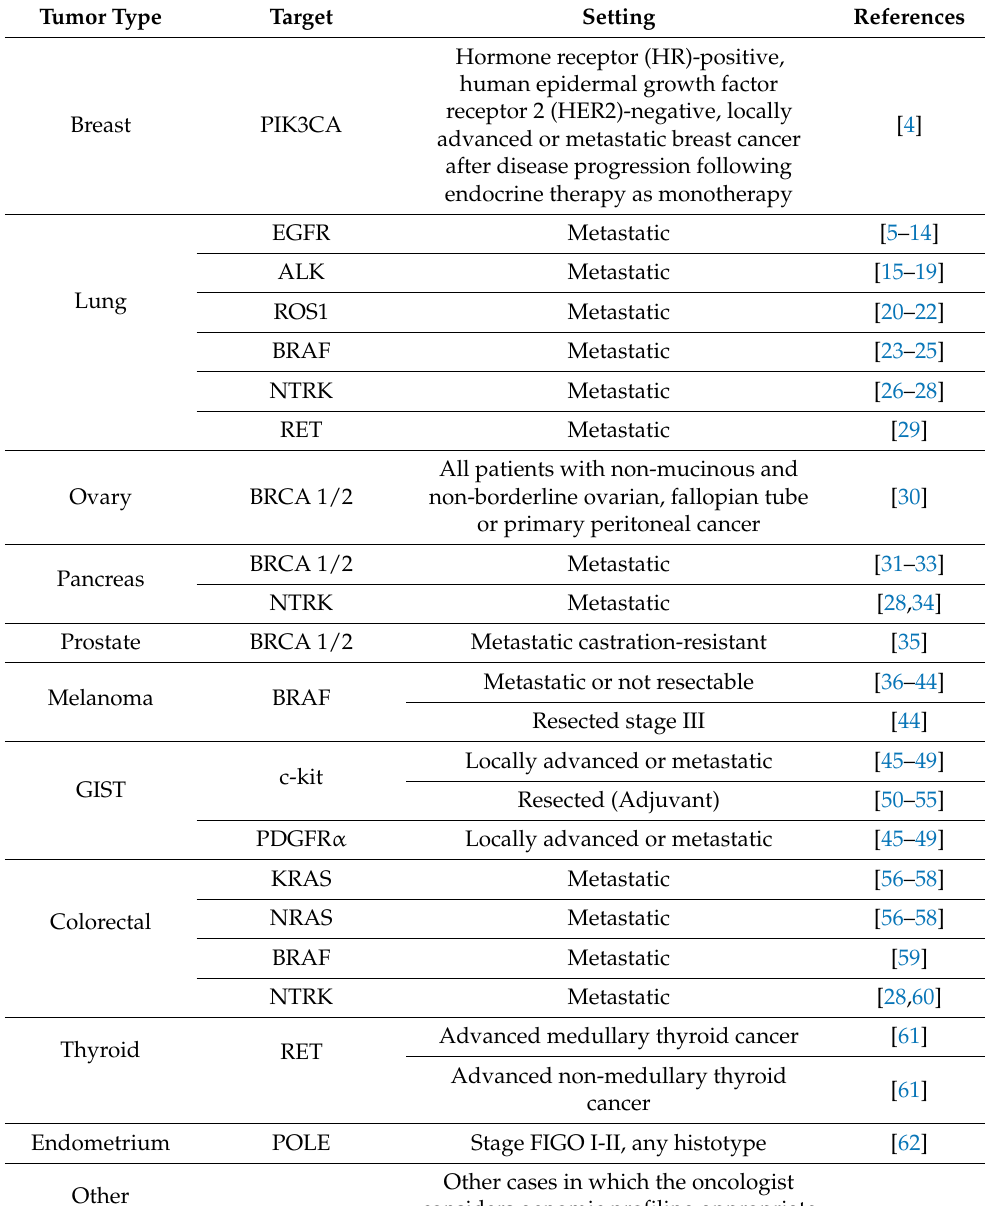
Table 1. Included malignancies and related